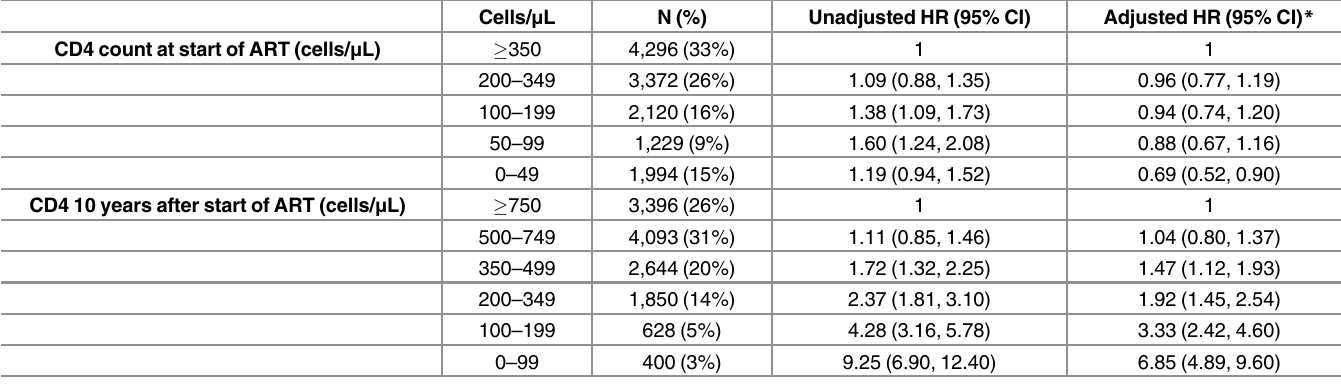
Table 4. Unadjusted and adjusted hazard ratios (HR) according to CD4 count at start of ART and at 10 years after start of